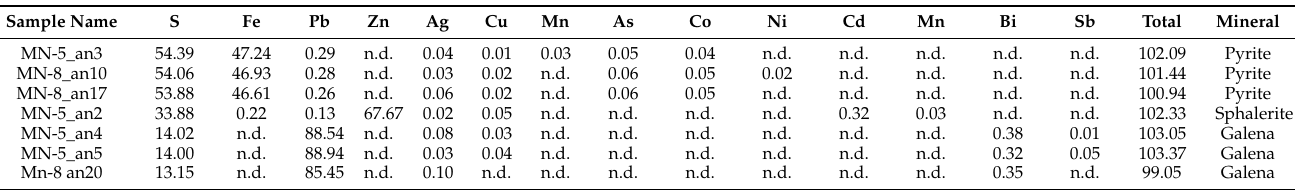
Table 1. Representative EPMA results (wt.%) of common sulfides from the M ă n ă il ă ore deposit: pyrite, sphalerite, and